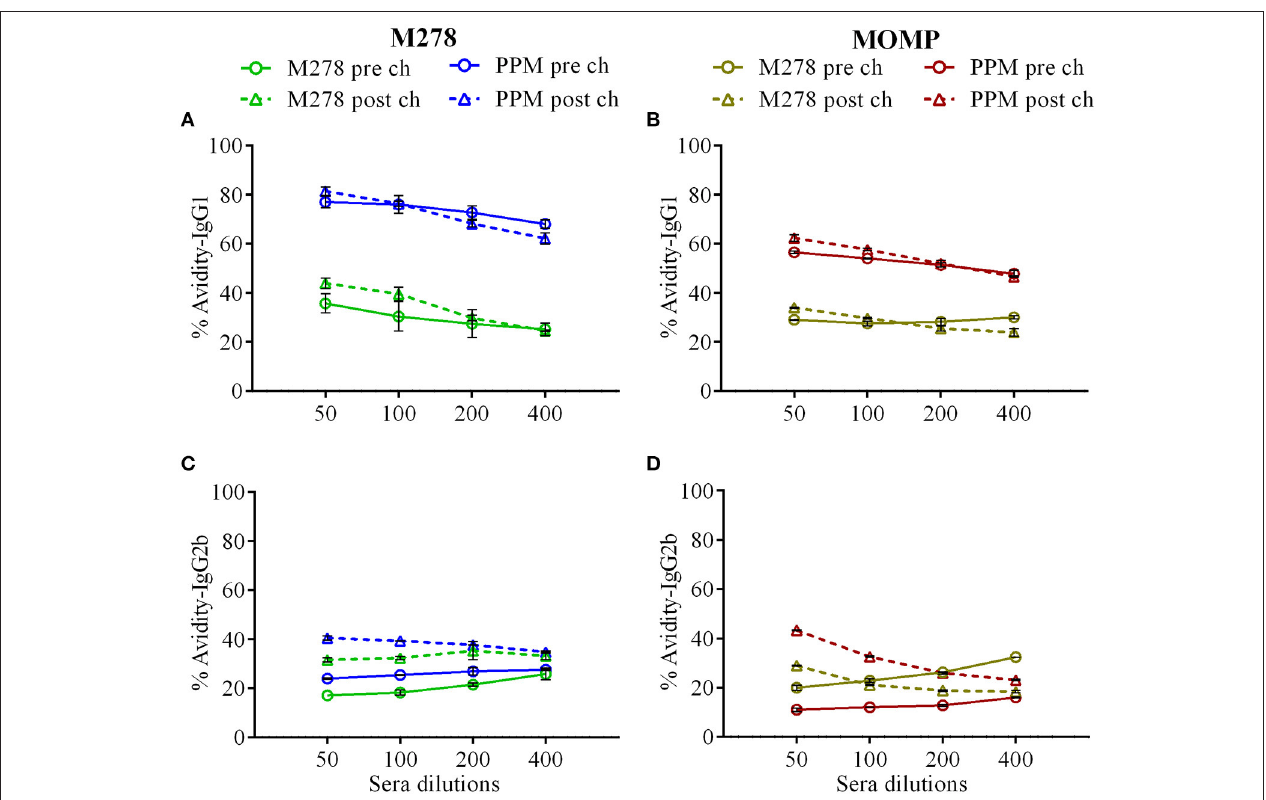
FIGURE 6 | Avidity index of Chlamydia -specific serum IgG1 and IgG2b antibodies. Avidity-ELISA was conducted using pooled sera from immunized and C. muridarum challenged immunized mice to determine the avidity index (%) for M278-specific IgG1 (A) , MOMP-specific IgG1 (B) , M278-specific IgG2b (C) and MOMP-specific IgG2b (D) antibody isotypes. Each data point represents the mean ± standard deviation of duplicate samples. M278 (bare M278-immunized group); PPM (PLA-PEG-M278)-immunized group; pre ch (pre-challenge); post ch